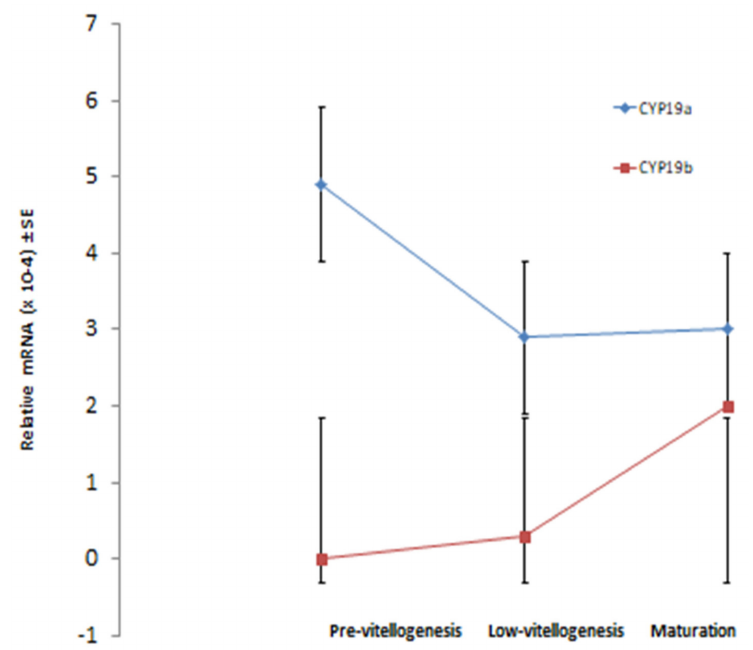
Figure 8. The transcription of ovary aromatase (CYP19a) and brain aromatase (CYP19a) at various stages of oocytes in vitellogenesis and maturation of female blue gourami [37]. Both GH and IGF1 are involved in oogenesis, as well as prolactin (PRL) [35,50,62] (Figure 9). The levels of GH and PL mRNA genes were found to be relatively constant during growth and oogenesis, and no significant di ff erences were found (Figure 9) [35,50,62]. These hormones are integral hormones that a ff ect many biological processes, including reproduction.